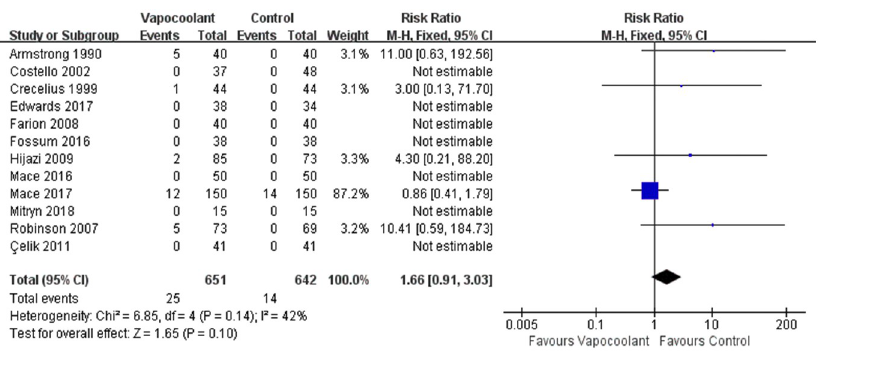
Fig 9. Forest plot of adverse